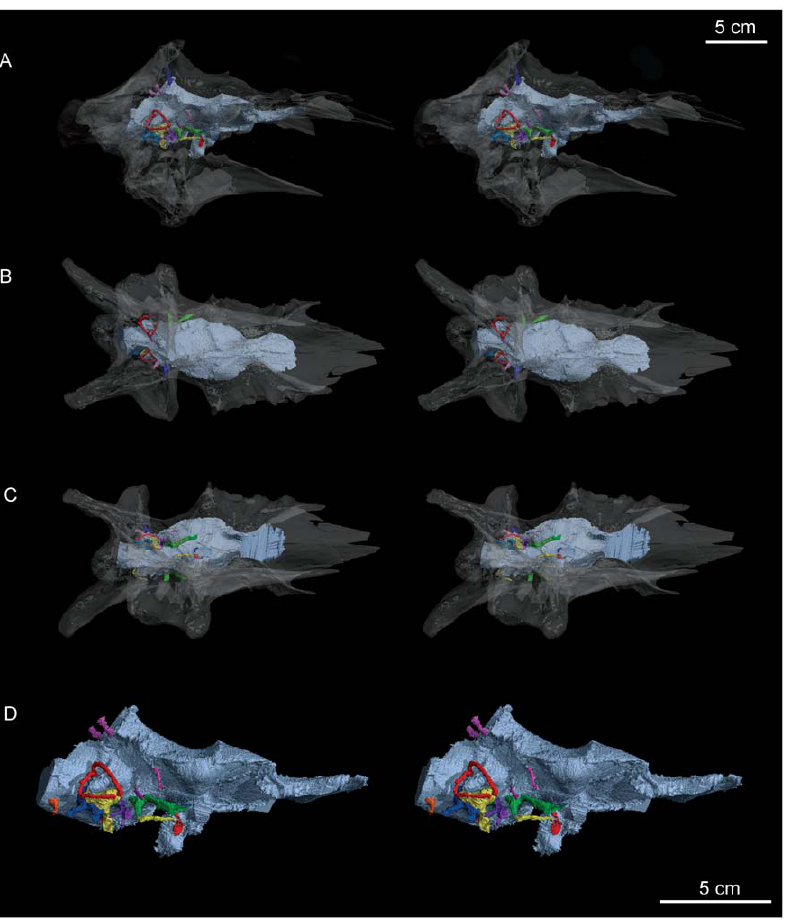
Figure 3. Stereopairs of the braincase of Alioramusaltai (IGM 100/1844) rendered transparent. This rendering reveals casts of the endocranial cavity, cranial nerve roots, selected vasculature, and the inner ear in dorsal (A), right lateral (B), and ventral (C) views, and the endocast with labeled structures in right lateral view (D). The upper right scale bar refers to A–C.